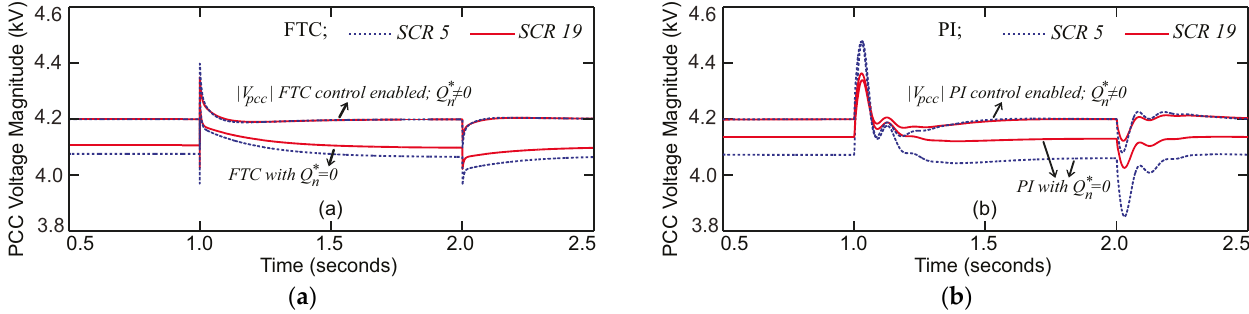
Figure 15. Impact of the grid strength on the PCC voltage magnitude with different controllers: ( a ) proposed FTC and ( b ) conventional PI controller.